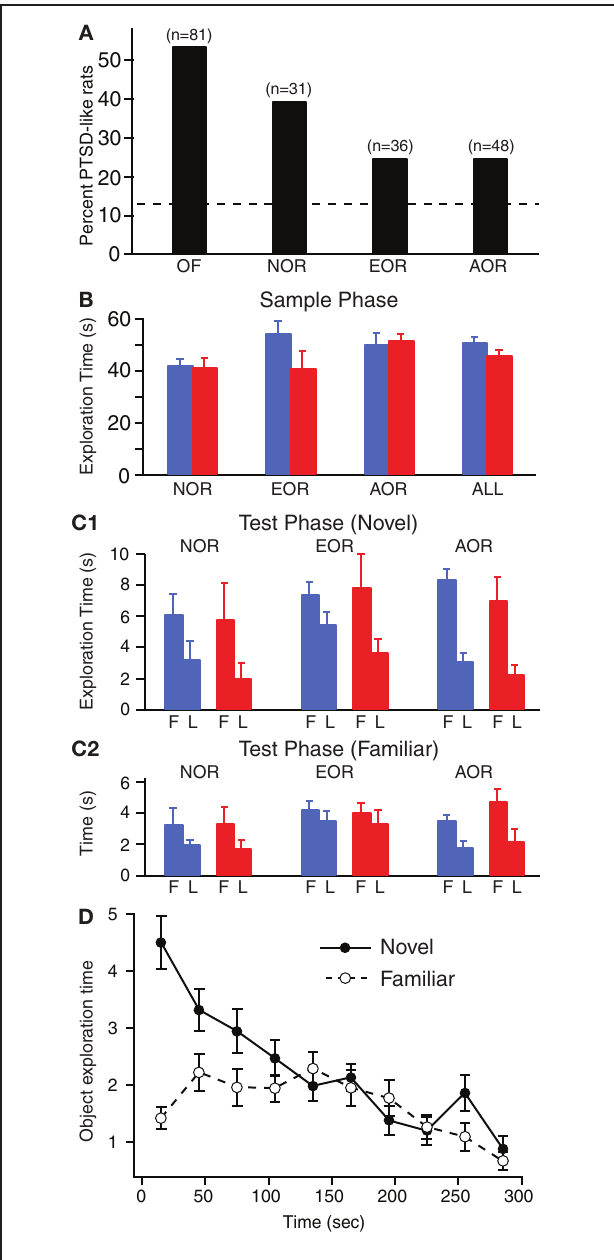
FIGURE 2 | Incidence of PTSD-like phenotype and common patterns of exploratory behavior across the NOR, EOR, and AOR tasks. (A) Different samples of rats were tested on the EPM one week after predatory threat and classified as PTSD-like if they failed to explore the open arms. Depending on the sample ( n ’s above each bar), prior to predatory threat, the rats were either subjected to the open field test (OF) or one of the object (NOR) or object-place recognition (EOR, AOR) tasks. (B) Total time exploring objects during the sample phase of the three tasks in Resilient (blue) vs. PTSD-like (red) rats. Data obtained in the three rat samples is combined on the right (ALL). (C) Time exploring novel (C1) or familiar (C2) item during the first (F) and last minute (L) of the testing phase in Resilient (blue) vs. PTSD-like (red) rats. (D) Fluctuations in time spent exploring the novel (solid circles and continuous line) or familiar (empty circles and dashed line) item during the test phase of the AOR task. The data is plotted in 30s